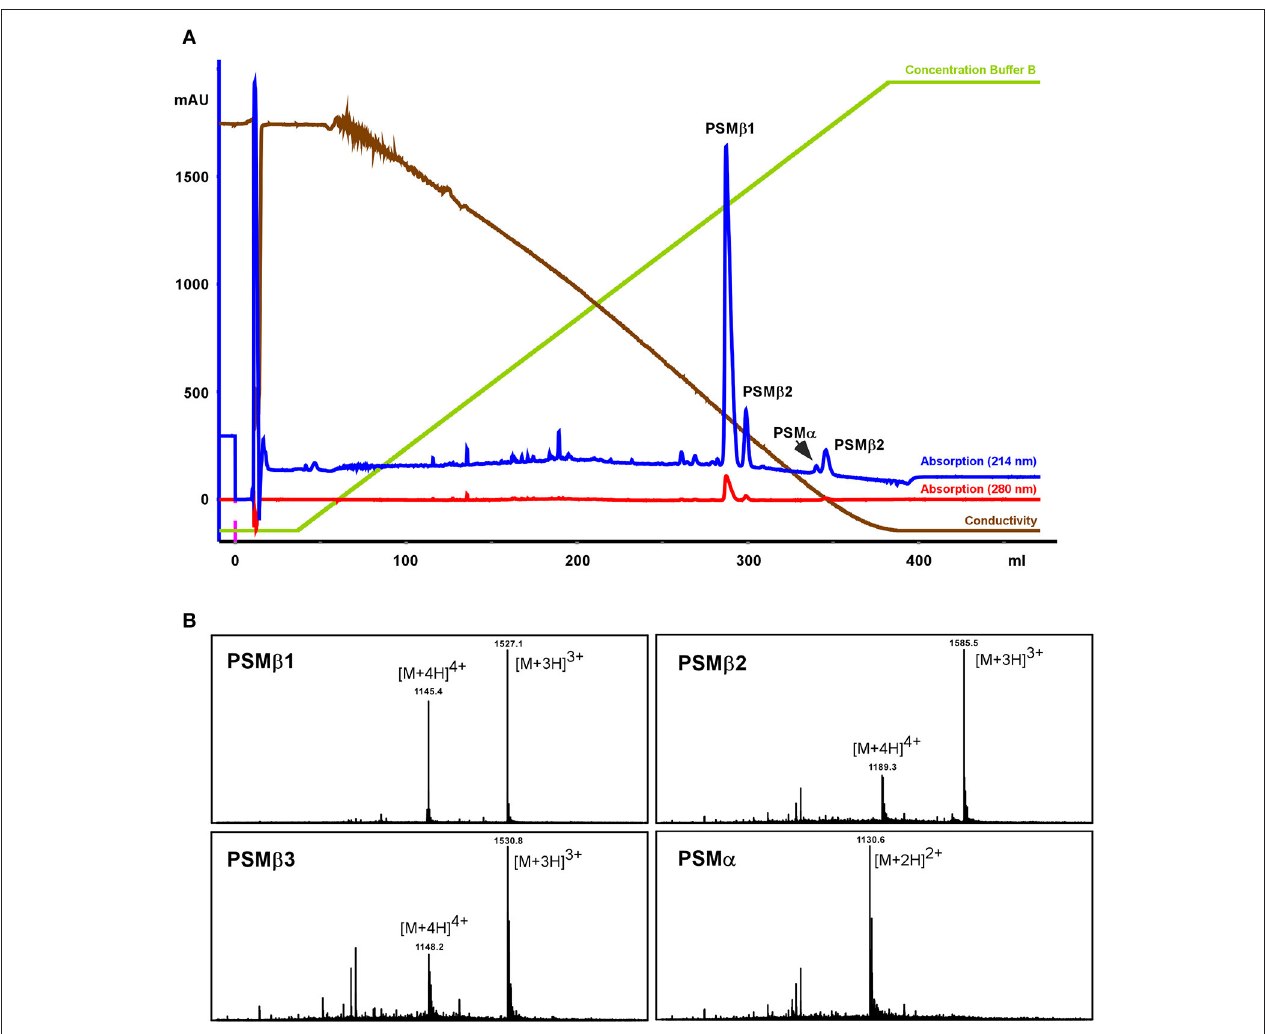
FIGURE 2 | Purification of S. haemolyticus PSMs. S. haemolyticus PSMs were purified from stationary-phase culture filtrate by initial chromatography on SOURCE PHE material and subsequent high-resolution HPLC on C18 material, shown in (A) . Peaks in the elution range of PSMs were then further analyzed by RP-HPLC/MS (B)